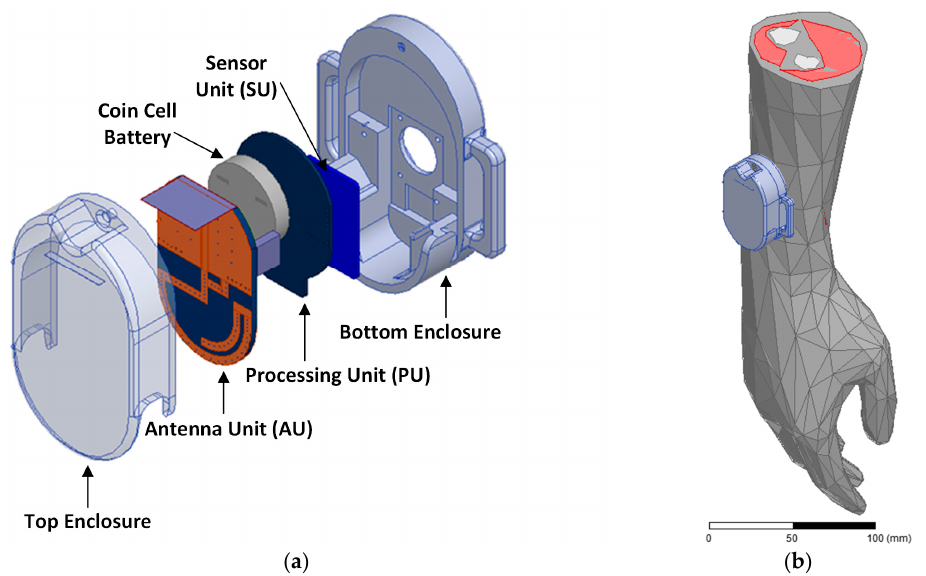
Figure 6. Wrist-worn wireless SpO2 sensor: ( a ) Exploded view of the Sensor Device; ( b ) Sensor device on voxel-based phantom arm. on voxel-based phantom